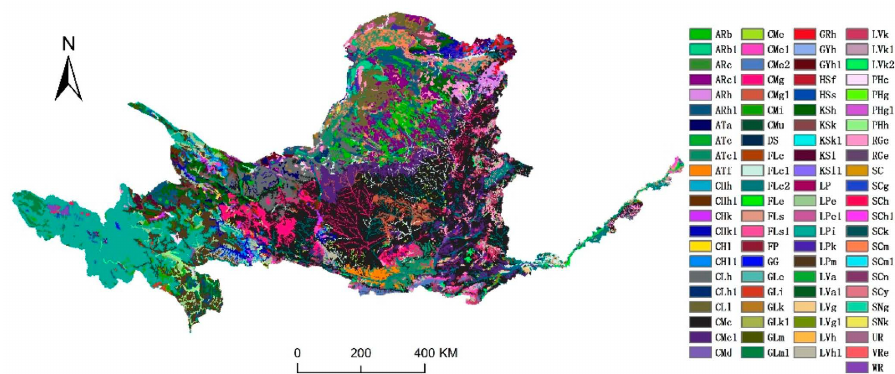
Figure 2. Sub basins division of the Yellow River Basin.